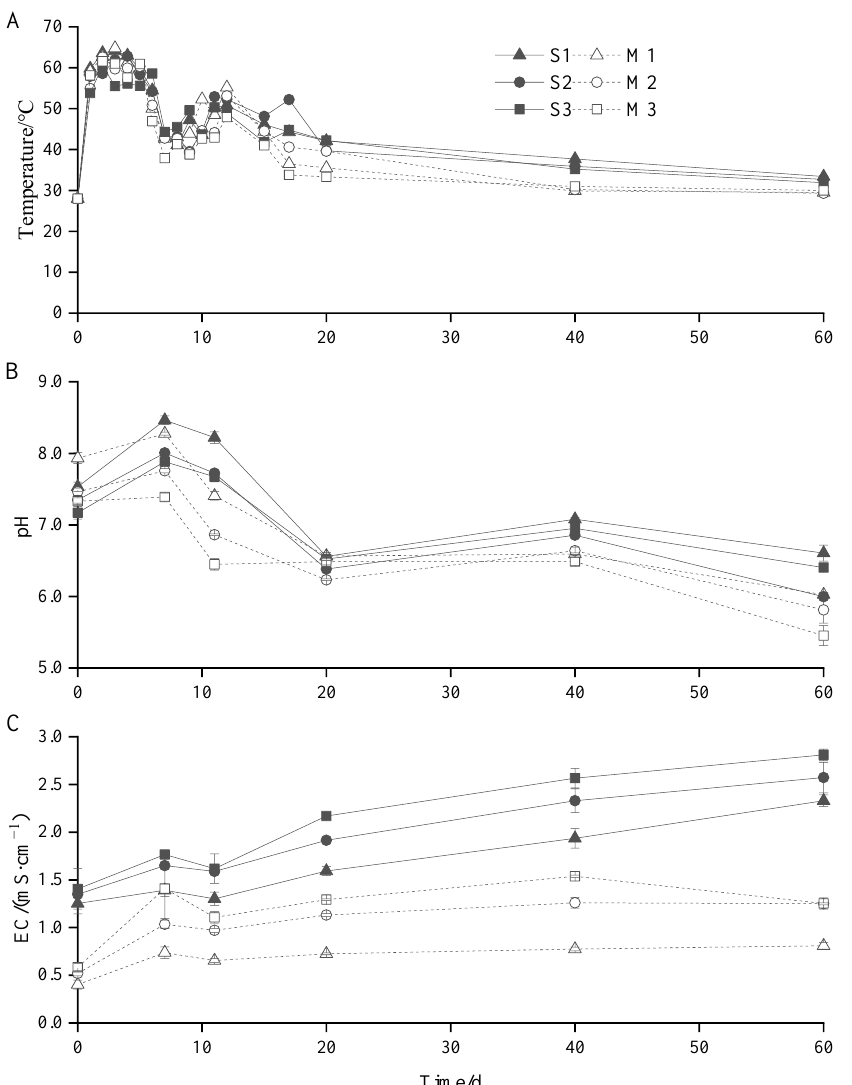
Figure 2. Variation in temperature( A ), Ph( B ), and EC( C ) during composting. S1: pig manure + straw; S2: pig manure + straw + 3% SSP; S3: pig manure + straw + 6% SSP; M1: pig manure; M2: pig manure + 3% SSP; M3: pig manure + 6% SSP.